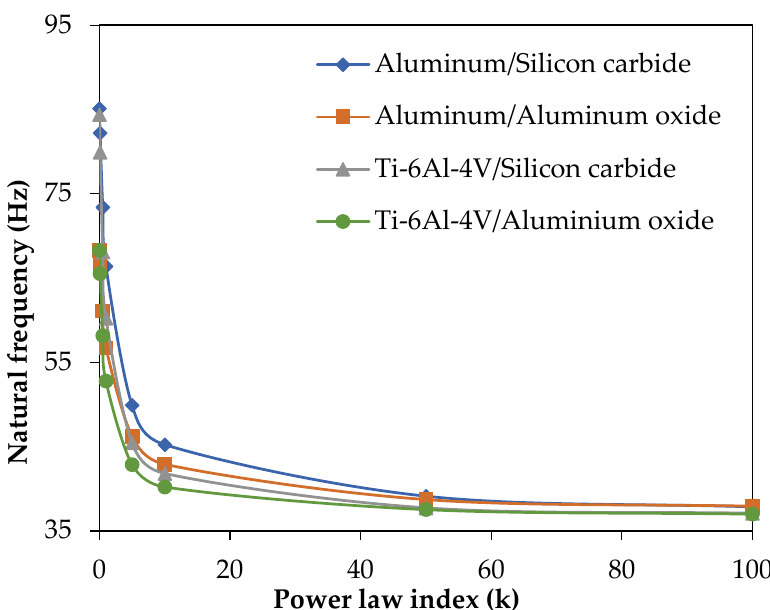
Figure 6. Variation of the natural frequency (first mode) with a power law index for different material combinations for re-entry vehicle nose shell structures.